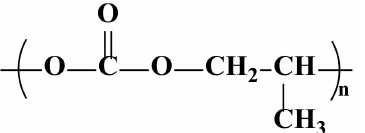
Figure 3. Chemical structure of PPC